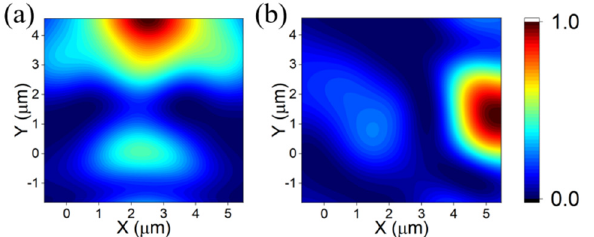
Figure 10. ( a ) The normalized intensity distribution of the light fi eld in the X − Y plane when the incident light angle is 0 ◦ has a clear phenomenon of deflection out to the positive y -axis at the transmissive end. ( b ) The normalized intensity distribution of the light field in the X − Y plane when the incident light angle is 16 ° ; the re fl ective end completely behaves as directly re fl ected light from the metasurface substrate.